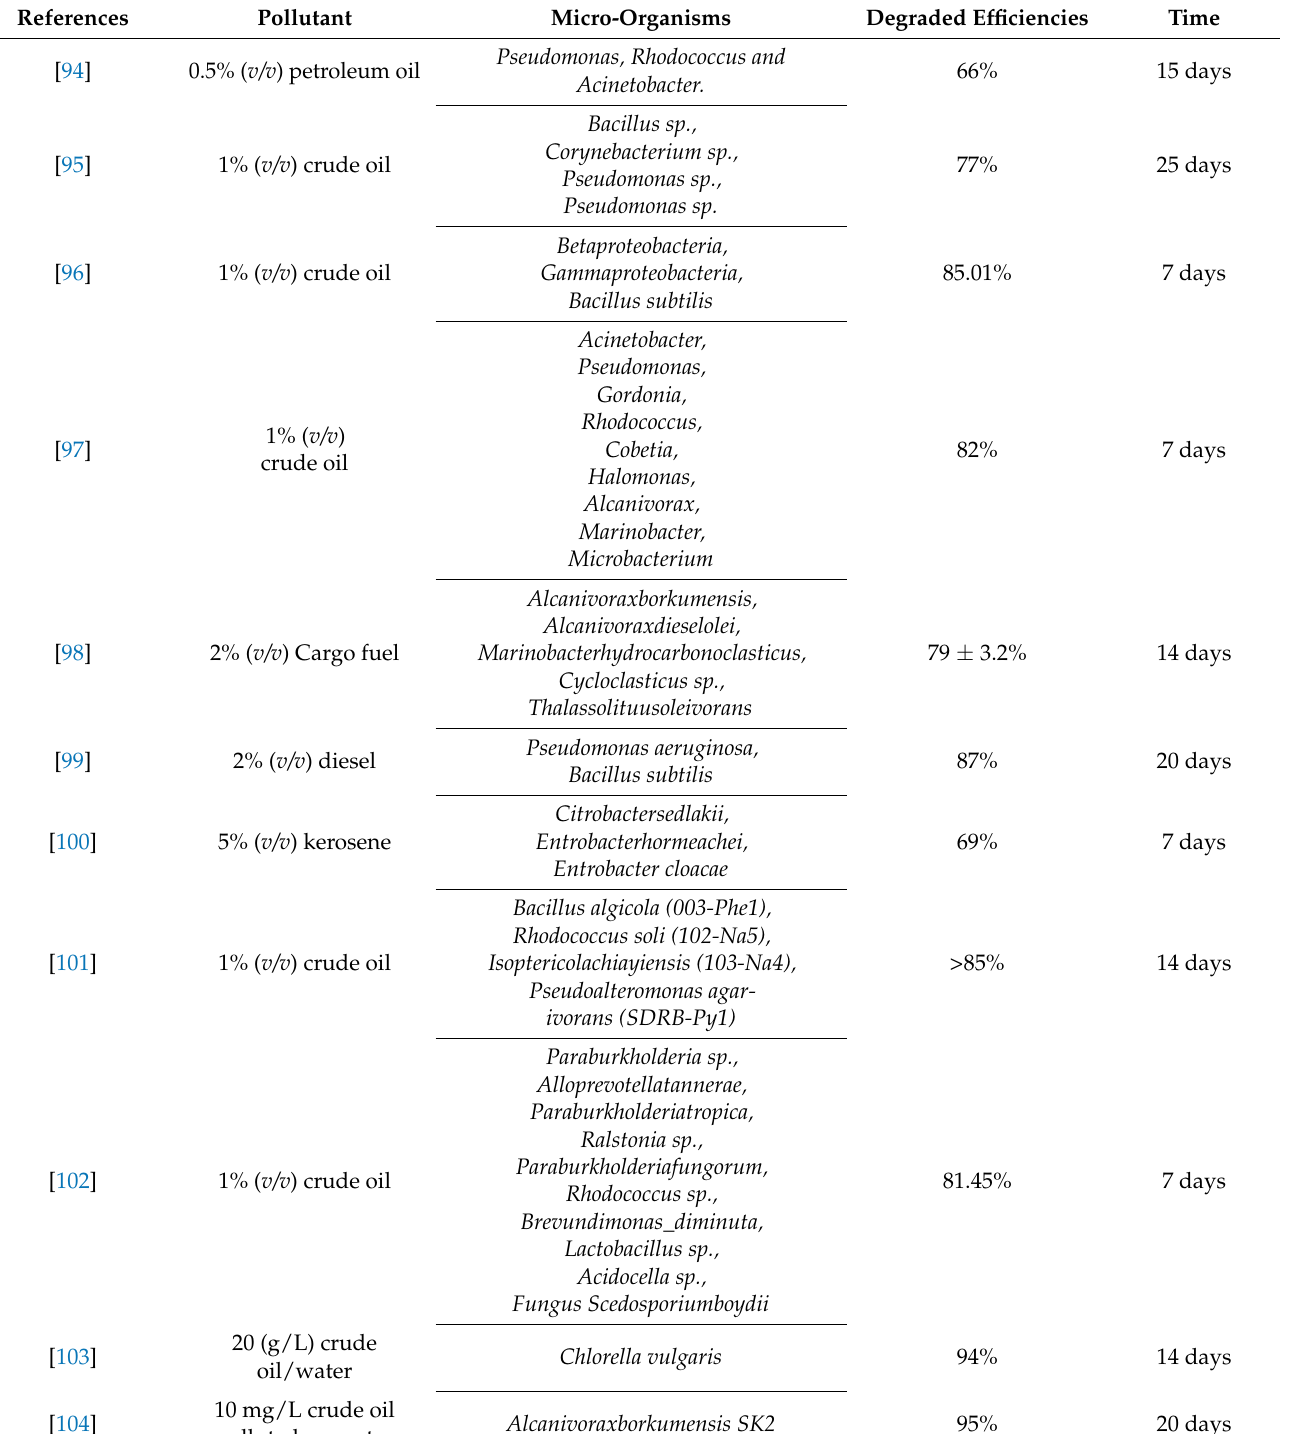
Table 5. List of selected studies for degradation of petroleum hydrocarbons using bioaugmentation